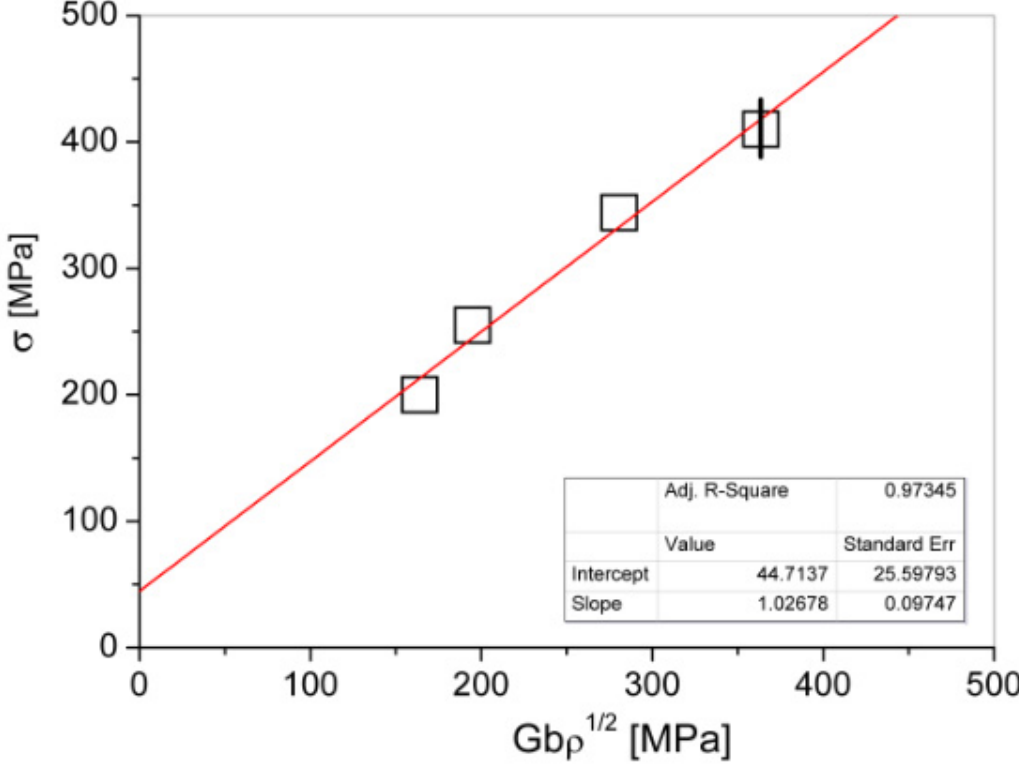
Figure 11. True tensile stress versus the square root of dislocation density. The linear fit is shown in order to obtain the parameters in Taylor’s formula.